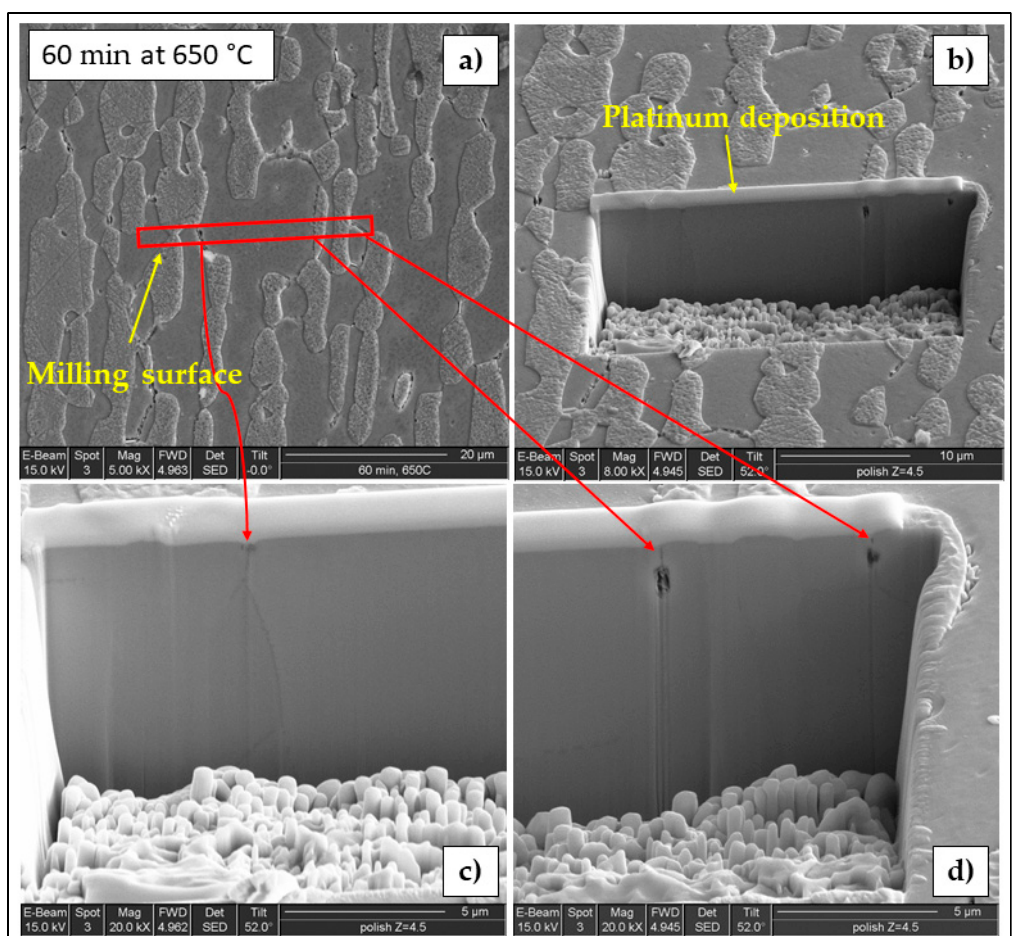
Figure 12 . Field emission gun (FEG)-SEM images obtained on LDSS 2404 aged 60 min at 650 °C, after Figure 12. Field emission gun (FEG)-SEM images obtained on LDSS 2404 aged 60 min at 650 ◦ C, DL-EPR test, and before ( a ) and after ( b , c , d ) focused ion beam (FIB) milling. after DL-EPR test, and before ( a ) and after ( b – d ) focused ion beam (FIB) DL-EPR produced a deep large crater at α / γ phase boundaries also on the sample aged at 750 °C for 60 min (indicated by the arrow in Figure 13c). In this case, the attacks at the α / γ interface were also documented by SEM in BSE at high magnification with the sample tilted at 80° (Figure 13d).